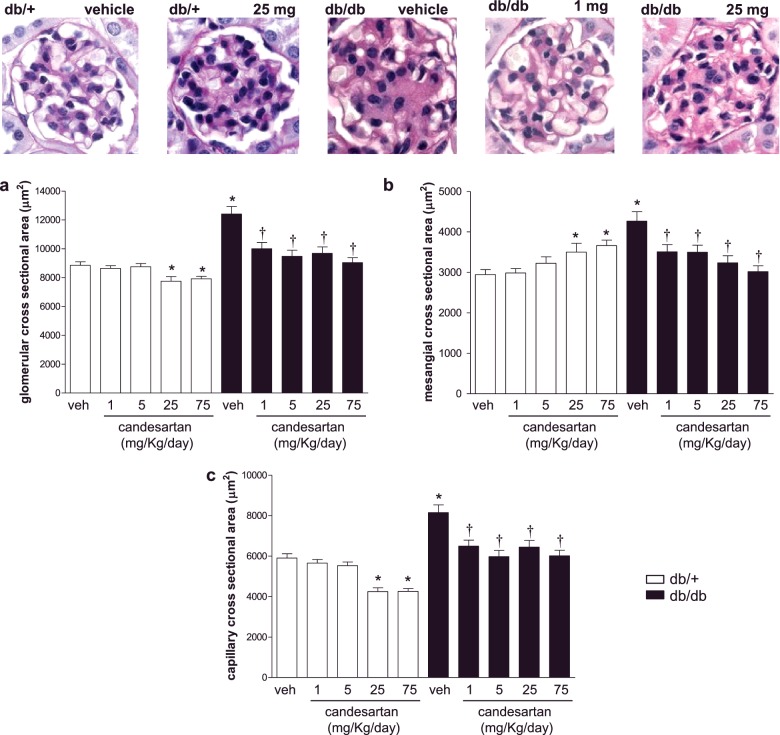
Increasing doses of candesartan reduce glomerular area enlargement in the kidney cortex of db/db miceKidney morphometry. Glomerular (a), mesangial (b) and capillary (c) cross-sectional area were evaluated in kidney cortex from db/+ and db/db mice treated with vehicle or candesartan 1 mg/kg/d, 5 mg/kg/d, 25 mg/kg/d, 75 mg/kg/d. *P<0.05 compared with vehicle-treated db/+; †P<0.05 candesartan-treated db/db compared with vehicle-treated db/db.